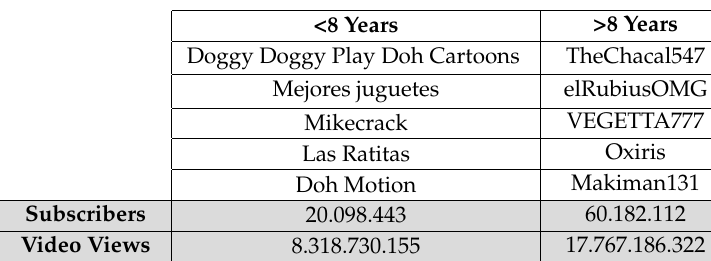
Table 2. Tentative age distribution according to the number of subscribers and video views in the top 10 Spanish YouTubers (5 May 2018).